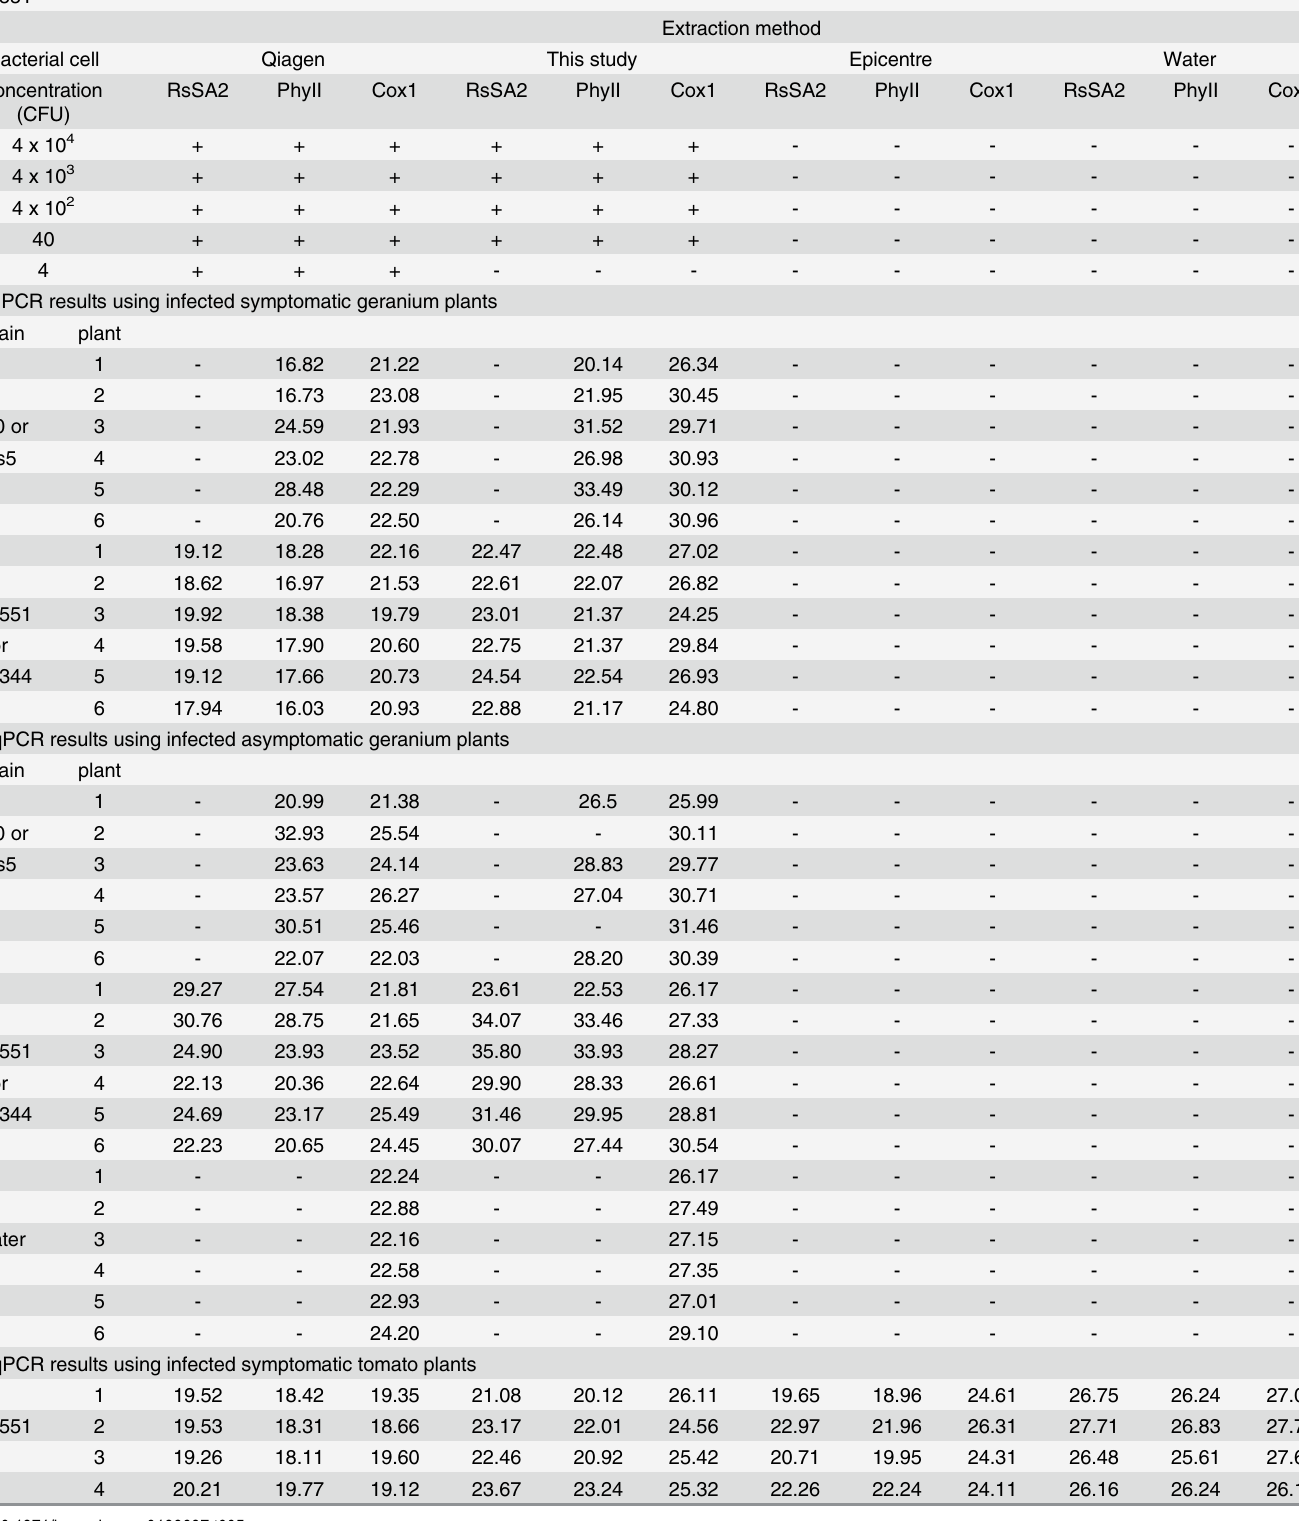
Table 5. A simultaneous comparison of extraction methods followed by our multiplex qPCR